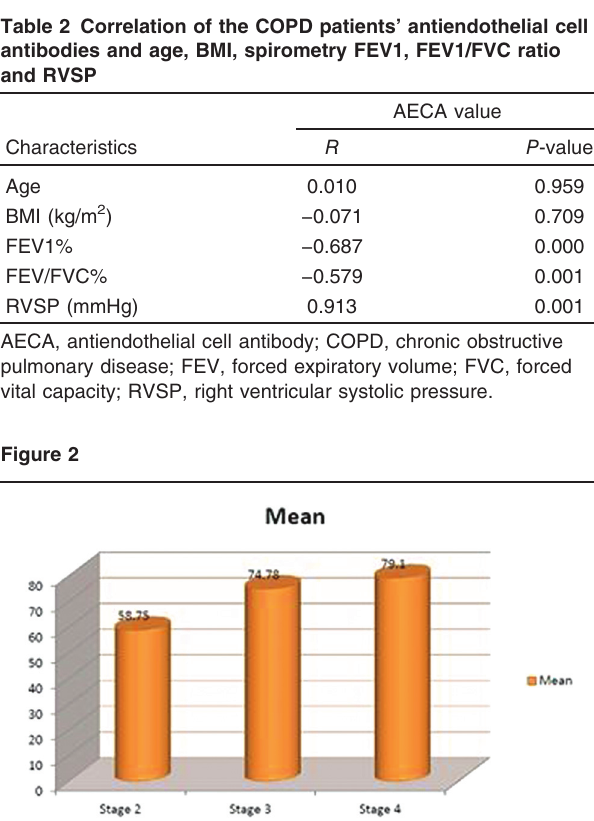
Statistical comparison of the stages of COPD patients with the anti- endothelial cell antibodies (AECA.ng/ml). AECA, antiendothelial cell antibody; COPD, chronic obstructive